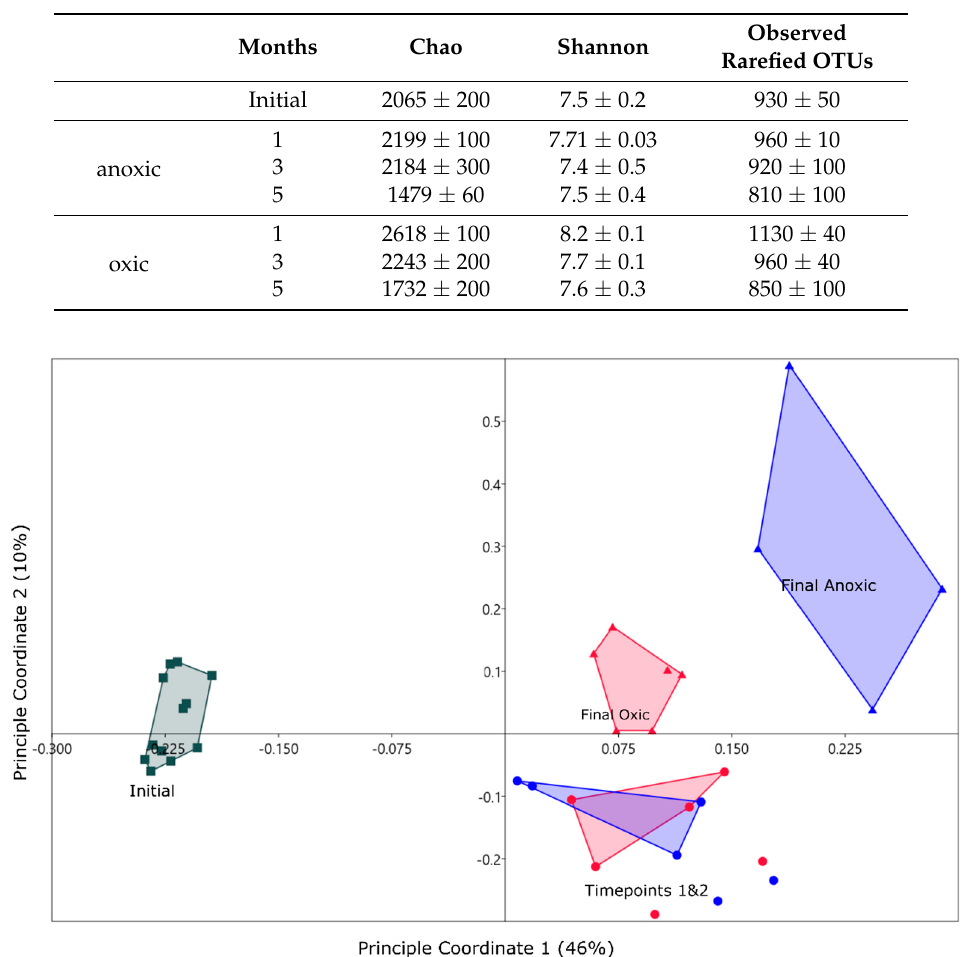
Figure 3. PCoA of the top 1000 OTUs from the initial (squares), oxic (red) and anoxic (blue) incubations. Final timepoints (month 5) are represented by triangles for both atmospheric conditions. Coordinate one represents 46% of the variance and coordinate two represents 10%. Convex hulls are connecting sample groups on the figure, done within PAST. Timepoints one and two represent month 1 and 3 sampling periods.